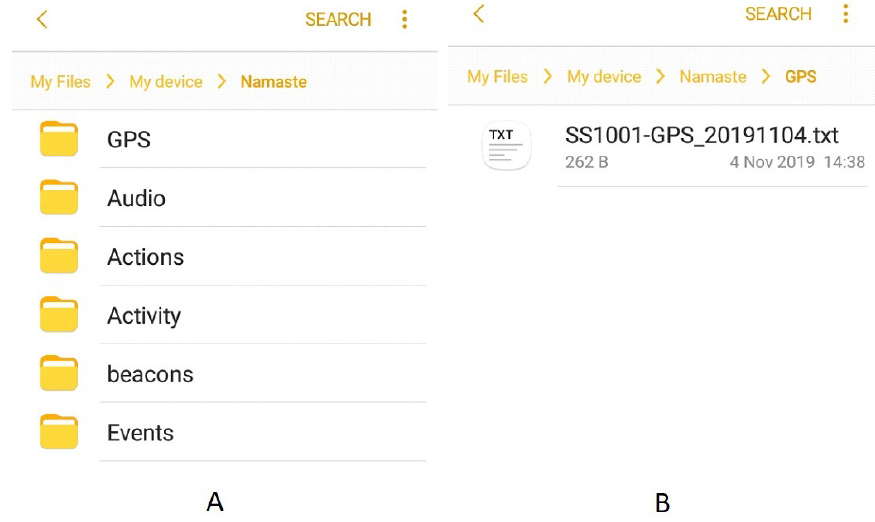
different sensors. The collected data then has to be exported to the format supported by the StandStrong Platform. More detail can be found at using pRMT is available on the RADAR-base